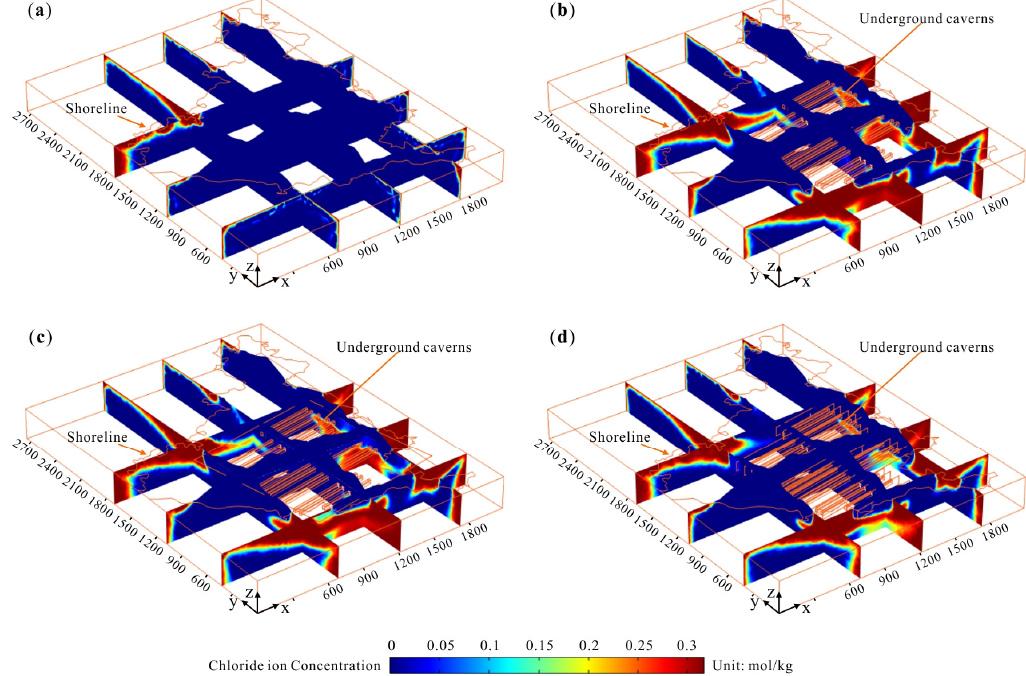
Figure 16. Contrast of seawater intrusion in fifty years: ( a ) un-excavated; ( b ) excavated; ( c ) horizontal water curtain system; ( d ) vertical water curtain system.